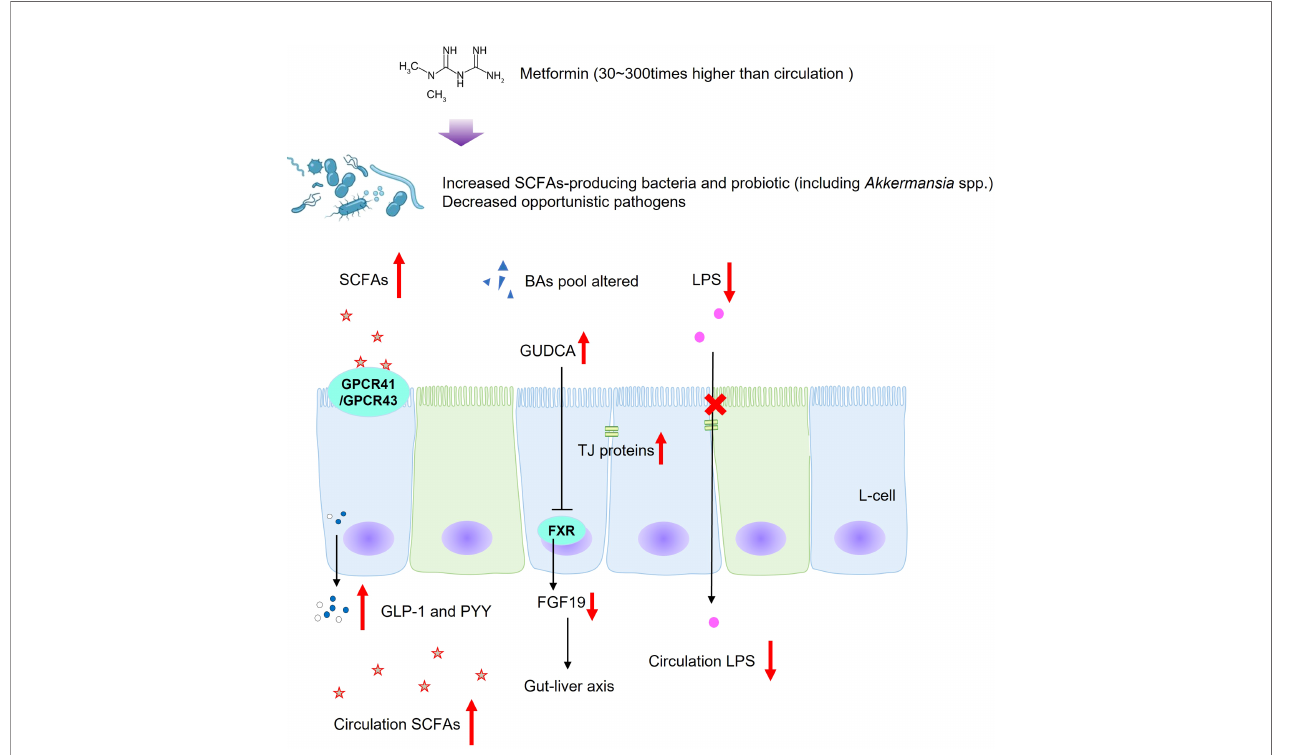
FIGURE 2 | Possible regulatory mechanisms of metformin on gut microbiota and microbial metabolites in T2DM. SCFAs, short-chain fatty acids; BAs, bile acids; LPS, lipopolysaccharides; GUDCA, glycoursodeoxycholic acid; GPCR43, G-protein-coupled receptor 43; GPCR41, G-protein-coupled receptor 41; FXR, farnesoid X receptor; TGR5, Takeda G protein-coupled receptor 5; GLP-1, glucagon-likepeptide-1; PYY, peptide; tyrosine-tyrosine; FGF19, fi broblast growth factor 19; TJ proteins, tight-junction